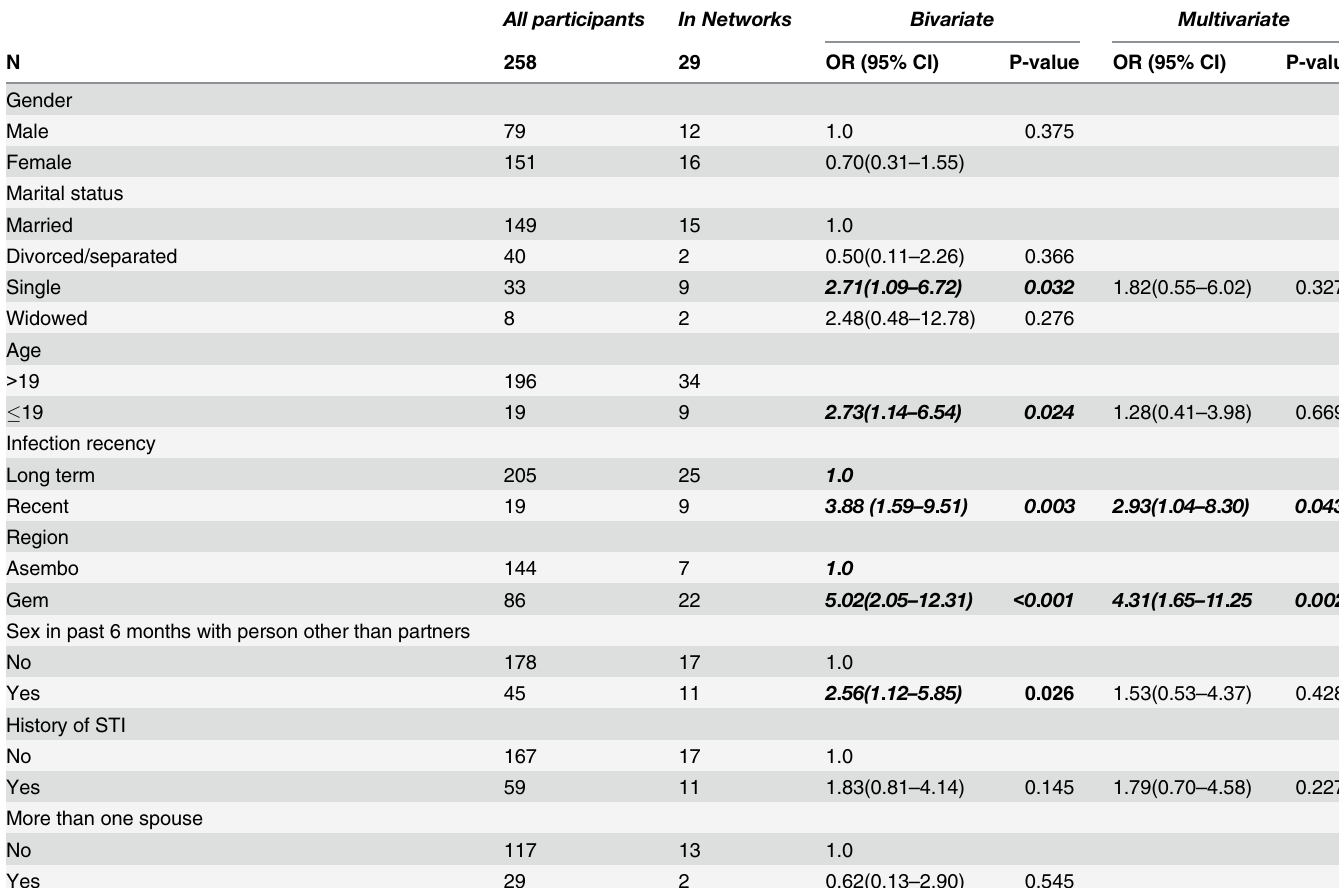
Table 3. Unadjusted and Adjusted Odds ratios and 95% CI for factors associated with transmission clusters among HIV-1 positive participants in Western